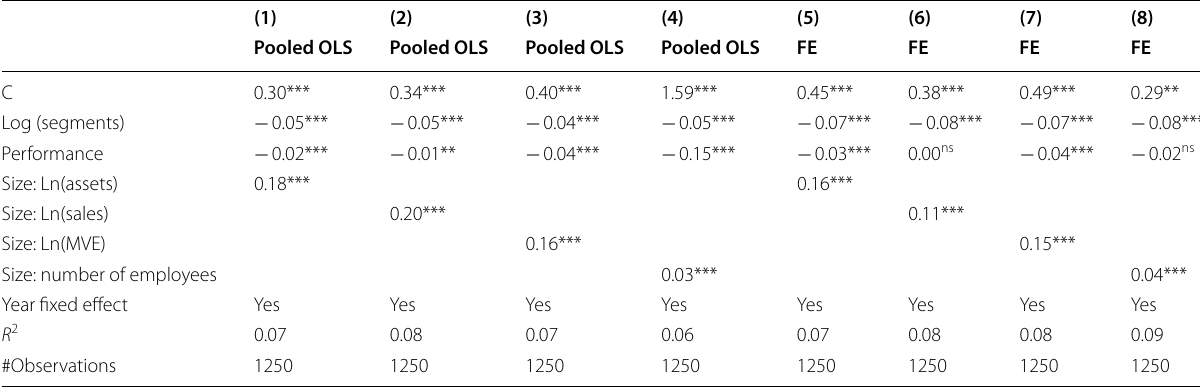
Table 11 Regression analysis of firm size (total asset, total sales, MVE and number of employees) and non-executive directors